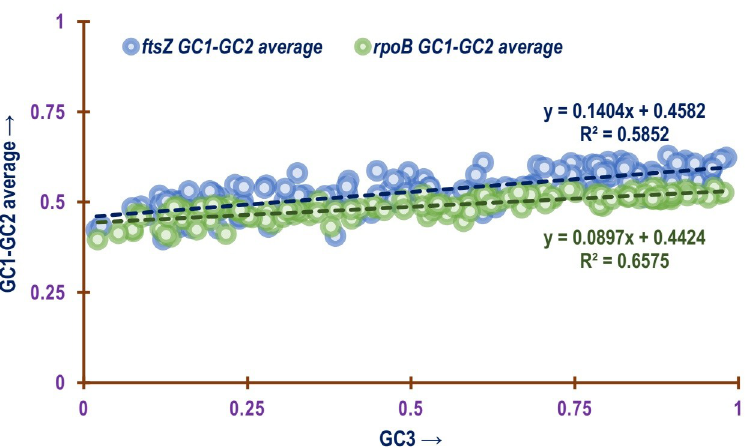
Fig 11. A plot showing the relationship of the average of GC1 and GC2 values (GC1-GC2) plotted against GC3 values of ftsZ and rpoB CDS of all the bacterial species involved in this study. The blue and green dashed line represents the trend of association between GC1-GC2 with GC3 of ftsZ and rpoB CDS respectively. The equation for the line and R 2 value for ftsZ and rpoB CDS is depicted in blue and green colours respectively.